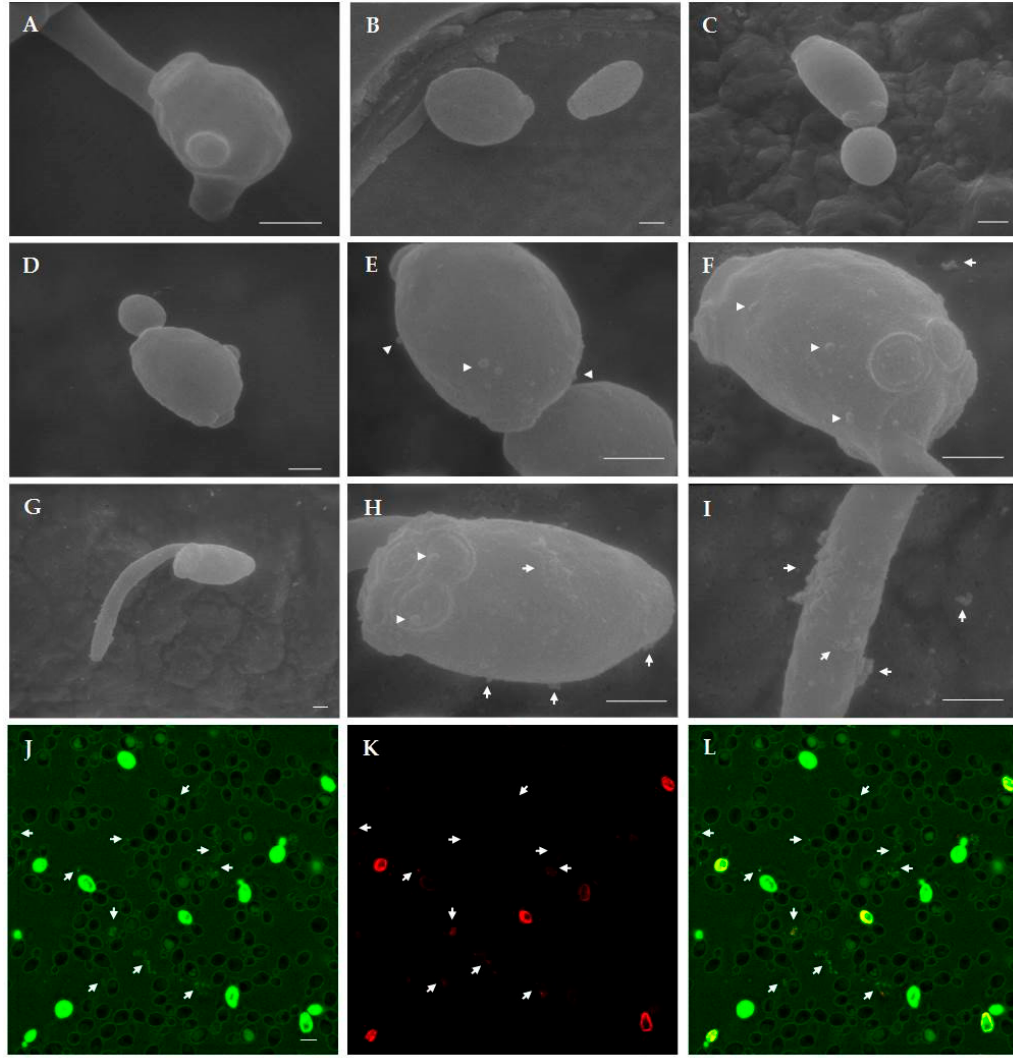
Figure 8. Scanning electron microscopy (SEM) and confocal microscopy images of Candida albicans cells treated with T11F. At SEM observation, structural and morphological alterations were evident after treatment with the peptide for 1 h (panels D – I ) in comparison to untreated (control) cells (panels A , B , C ). In panels E , F , H , and I , arrowheads indicate blebs and arrows indicate the leakage of material from yeast cells. Images in panels H and I show details of cell in panel G . ( A – I : Bar = 1 µ m). Confocal microscopy images after T11F treatment showed the leakage of material from yeast cells, indicated by arrows (panel J , FITC; panel K , PI; panel L , merge). ( J – L : Bar = 5 μ m).